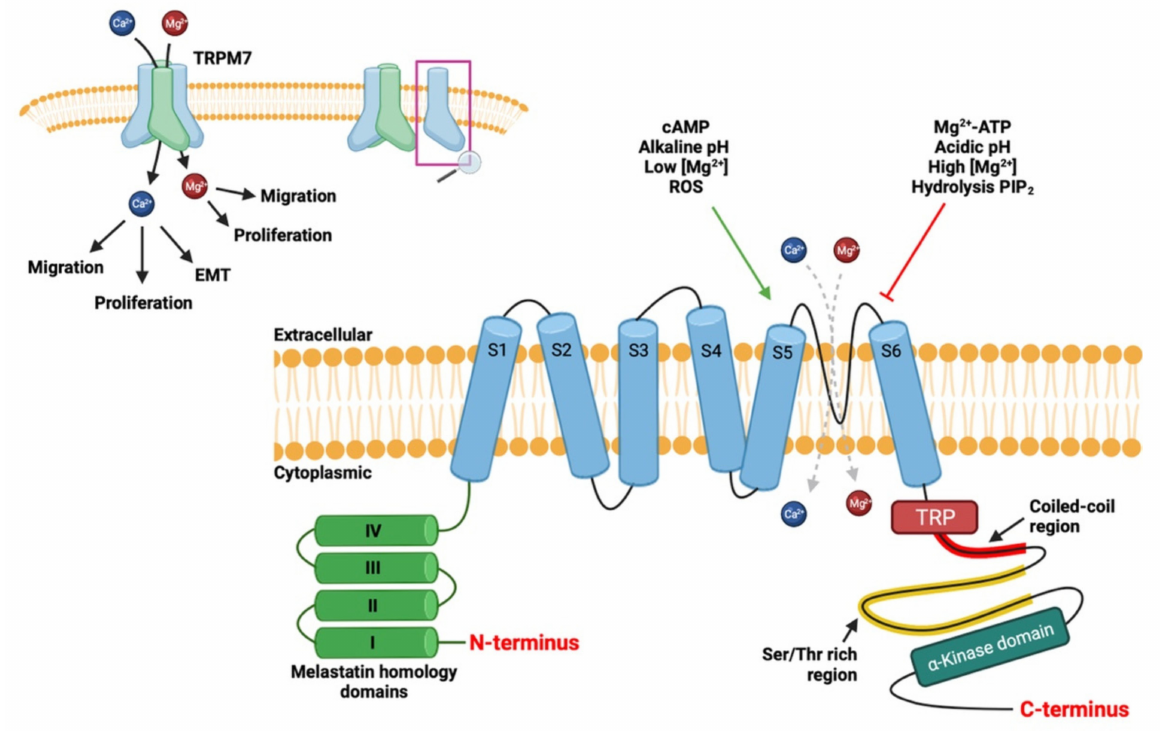
Figure 2. The TRPM7 ion channel is a hetero- or homo-tetramer with each subunit comprising of six transmembrane segments (S1 to S6). The channel pore is located between the segments S5 and S6. It is permeable to divalent magnesium (Mg 2+ ) and calcium (Ca 2+ ) cations which participate in migration, cell profiling and epithelial-mesenchymal transition (EMT). The amino-terminal (N-terminal) part has four homologies’ domains of melastatin members. The carboxy-terminal (C-terminal) part has a domain common to the channels of the transient receptor potential (TRP), followed by a coiled-coil region involved in multimerization of the channels, then a Serine/Threonine (Ser/Thr) rich region and a terminal COOH α -kinase domain. The kinase domain of TRPM7 has been shown to form a dimer, which can autophosphorylate as well as protein substrates. The channel can be activated by cAMP, alkaline pH, low magnesium concentration, reactive oxygen species (ROS) and inhibited by Mg 2+ -ATP, acidic pH, high magnesium concentration and hydrolysis of PIP 2 . “ ↑ “ means activation and “ ⊥ ” means inhibition. Created using source BioRender.com source, accessed on 13 September